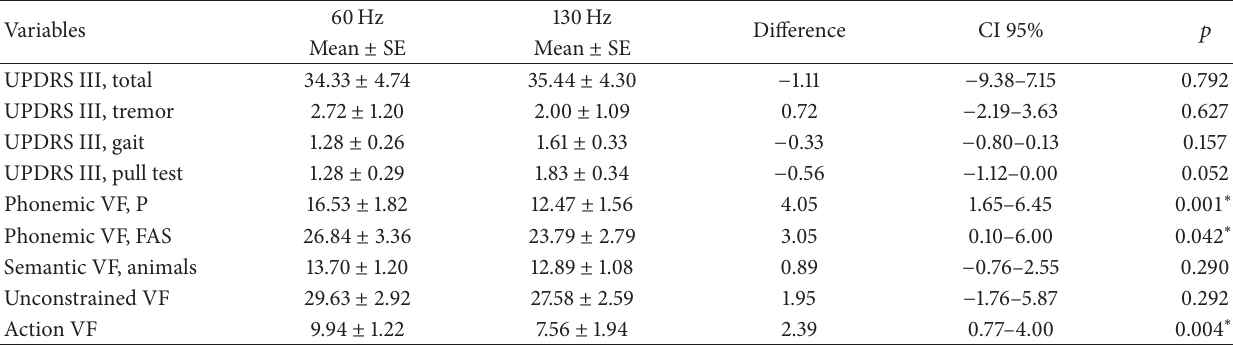
Table 4: Comparisons of the verbal fluency tasks and UPDRS-III between the different frequencies of SNT-DBS.